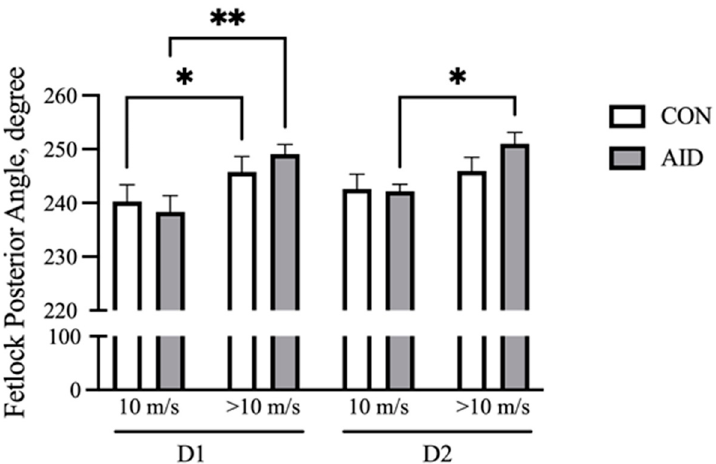
Figure 2. AID facilitates the retention of the fetlock range of motion. Horses performed consecutive bouts of exercise, with posterior fetlock angle measures recorded via high-speed cameras. The posterior angle of the right front increased over the course of the gallop on day 1 (D1) of exercise for both groups. AID horses retained a greater range of motion on day 2 (D2) of exercise. * denotes significance at p < 0.05, and ** denotes significance at p < 0.01.